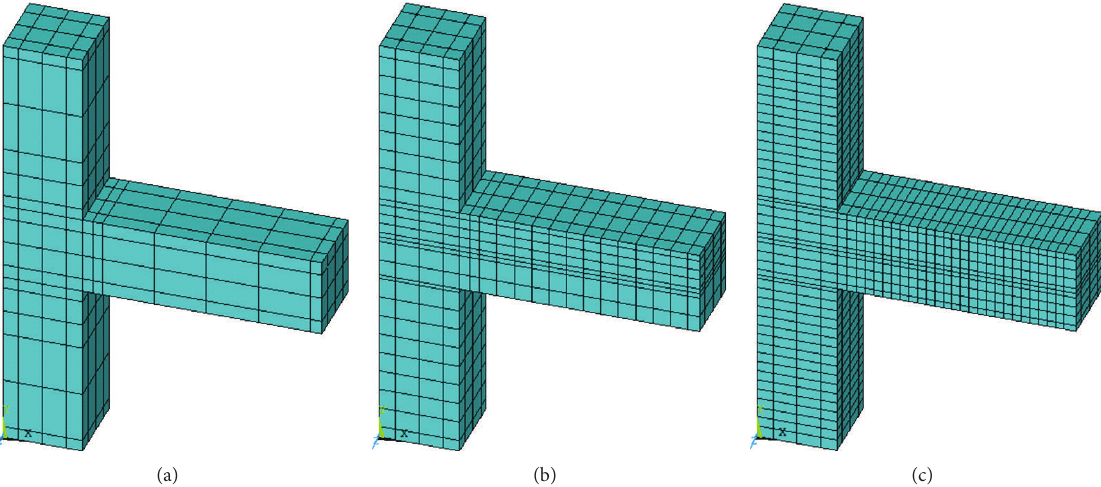
Figure 8: Concrete element modelling with ANSYS using the element “Solid 65” for (a) DCL-CONVEN, (b) DCL-SINGLE, and (c) DCL-